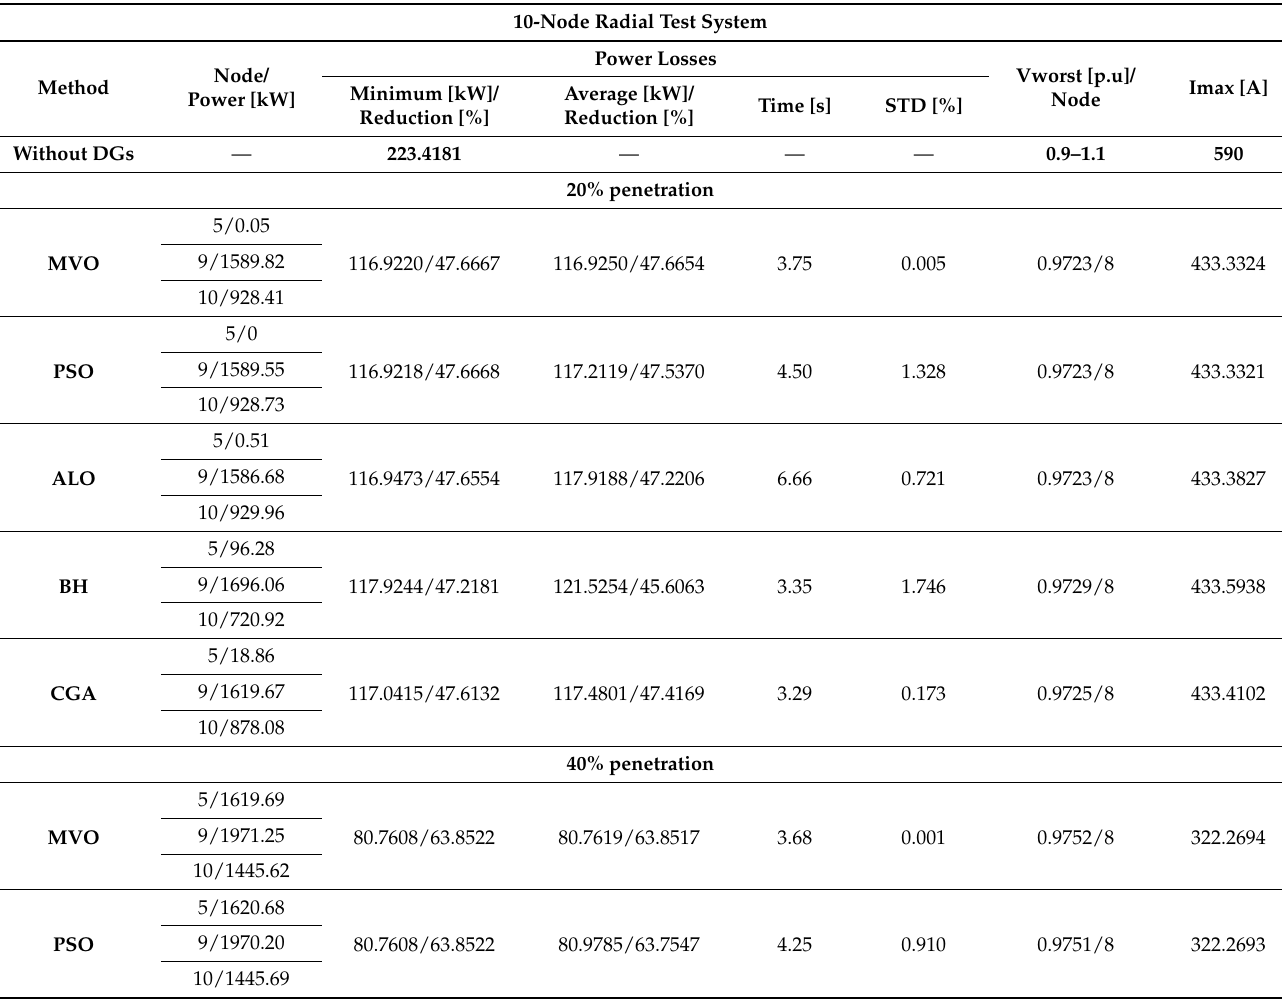
Table 7. Results of the simulations in the 10-node radial test